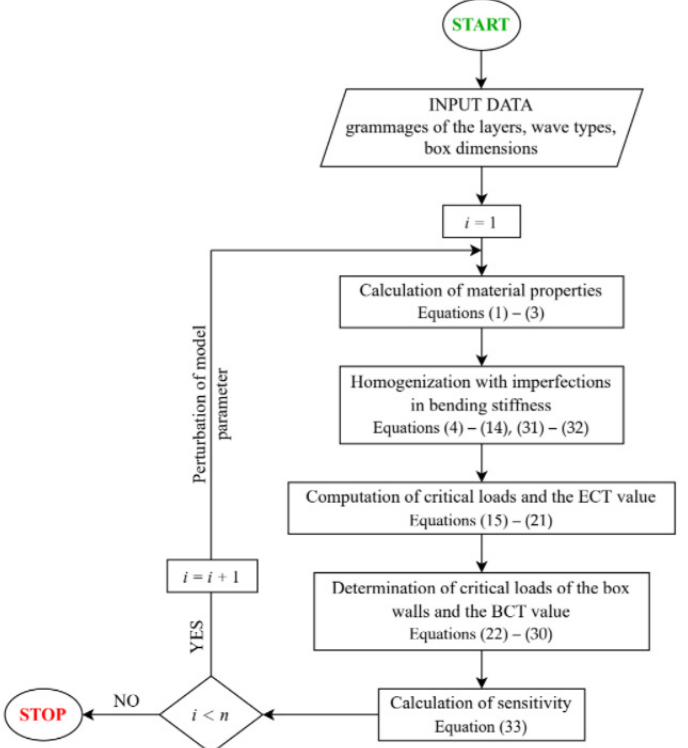
Figure 4. Flowchart of the algorithm for the determination of the non-local sensitivities of a five-play corrugated board.